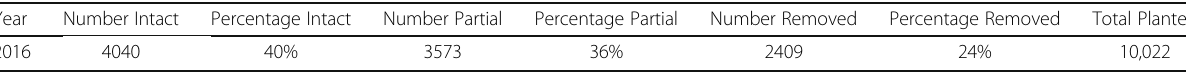
Table 4 2016 existing condition of PSFP shelterbelts in the state of